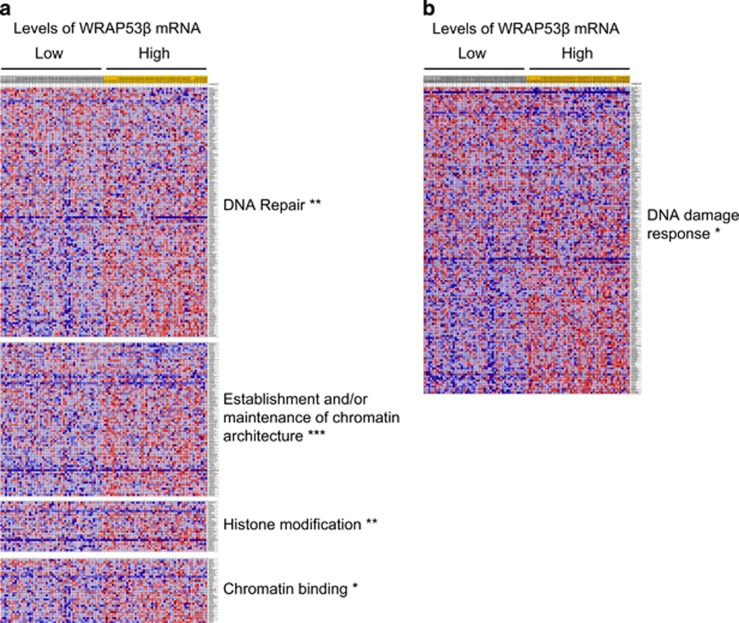
The levels of mRNA for WRAP53β and processes involved in the DNA damage response show a positive correlation in ovarian tumors. Heat map of mRNAs encoding proteins involved in the DNA damage response for tumors expressing highest and lowest levels of WRAP53β mRNA. (a) Gene set enrichment analysis of cohort III demonstrated that higher levels of WRAP53β mRNA were strongly associated with higher levels of mRNAs encoding factors involved in DNA repair, chromatin architecture, histone modification and chromatin binding (*P<0.05, **P<0.01, ***P<0.001 and false discovery rate <0.25). (b) Gene set enrichment analysis of cohort IV demonstrated that higher levels of WRAP53β mRNAs were strongly associated with higher levels of mRNAs encoding factors involved in the DNA damage response (*P<0.05, false discovery rate <0.25). Genes were ranked on the basis of their signal-to-noise ratios. Expression values, also based on the signal-to-noise ratios, are color coded: red=high, pink=moderate, light blue=low and dark blue=lowest